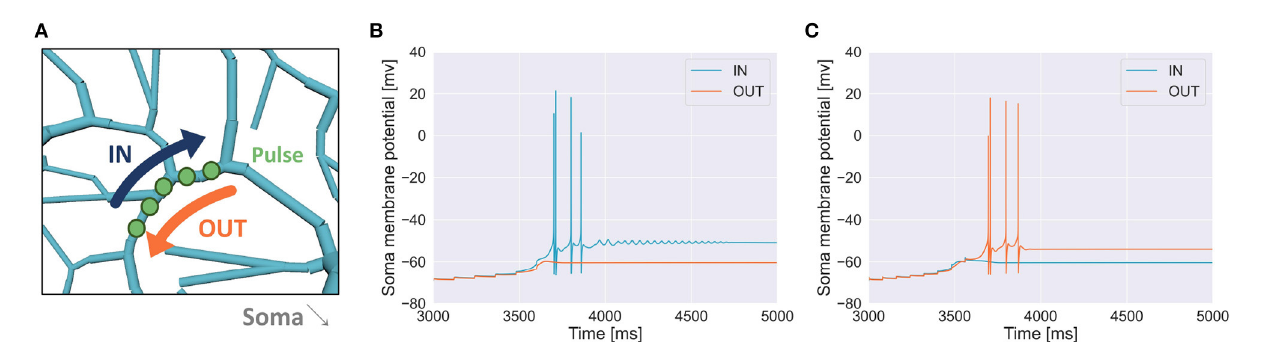
FIGURE4 (A) Schema of stimulation. A segment of spiny dendrites was stimulated sequentially in either IN direction (blue) or OUT direction (orange), where the number of compartments was 5, time interval for each stimulation was 120 ms and synaptic weight (or pulse amplitude) was 7.920 nA. The stimulated site was shown in Figure 1. (B) Membrane potential in the soma recorded during the stimulation in IN direction (blue) and that in OUT direction (orange) as in (A) , where the number of pulses was 6. (C) Another example when a different segment was stimulated, where the number of compartments was 8, interval was 80 ms and synaptic weight was 6.930 nA.